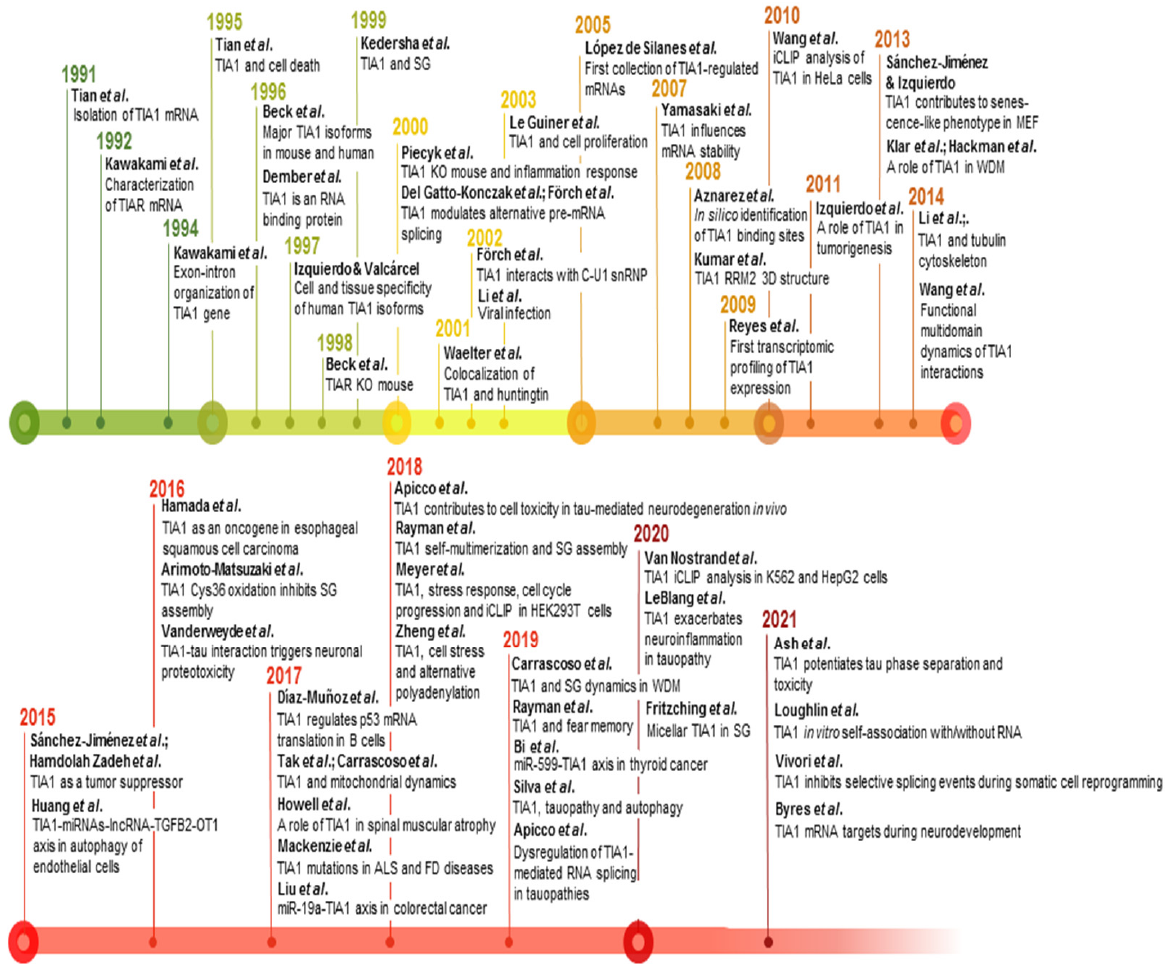
Figure 6. Timeline and milestones of TIA1 research. Milestones in the study of TIA1/TIA-1 found in PubMed/MEDLINE database. The references to build this figure are the following: [1–6,13,19– 21,24,31,33–38,40,42,44,46,73,77,83–114].